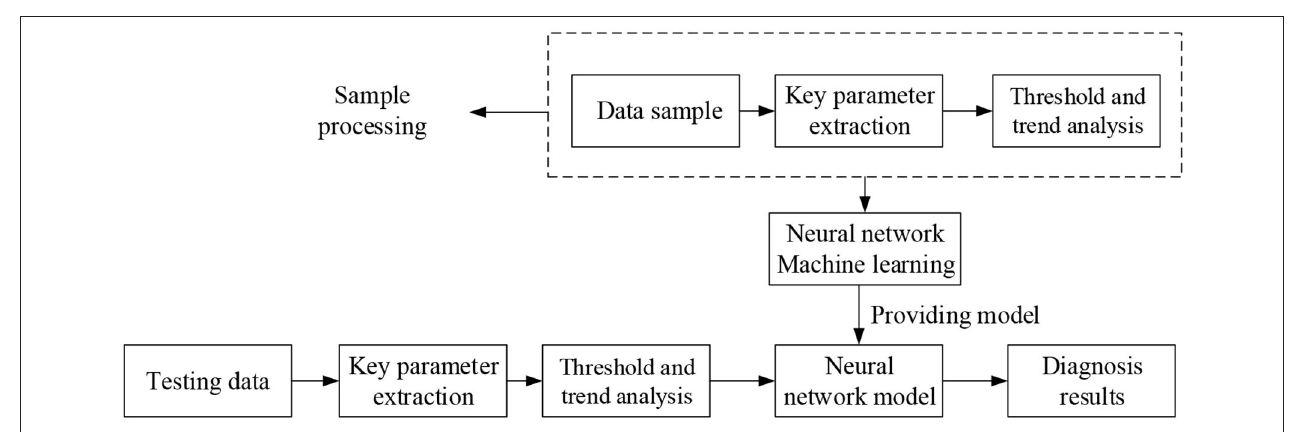
FIGURE 7 | Framework of neural network for fault diagnosis.